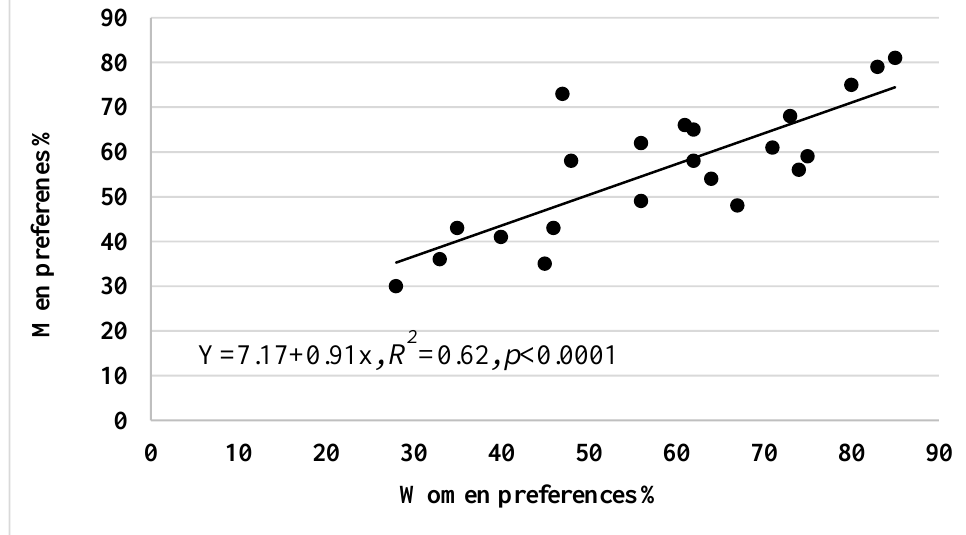
Figure 7. Women and men’s ranking s of varieties in the 2014/2015 season in Yélimané. There was also a significant positive relationship between yield and the PI in the 2013/2014 season ( R 2 = 0.19). The four varieties that had the highest yield were also those with the highest PI (Figure 8).